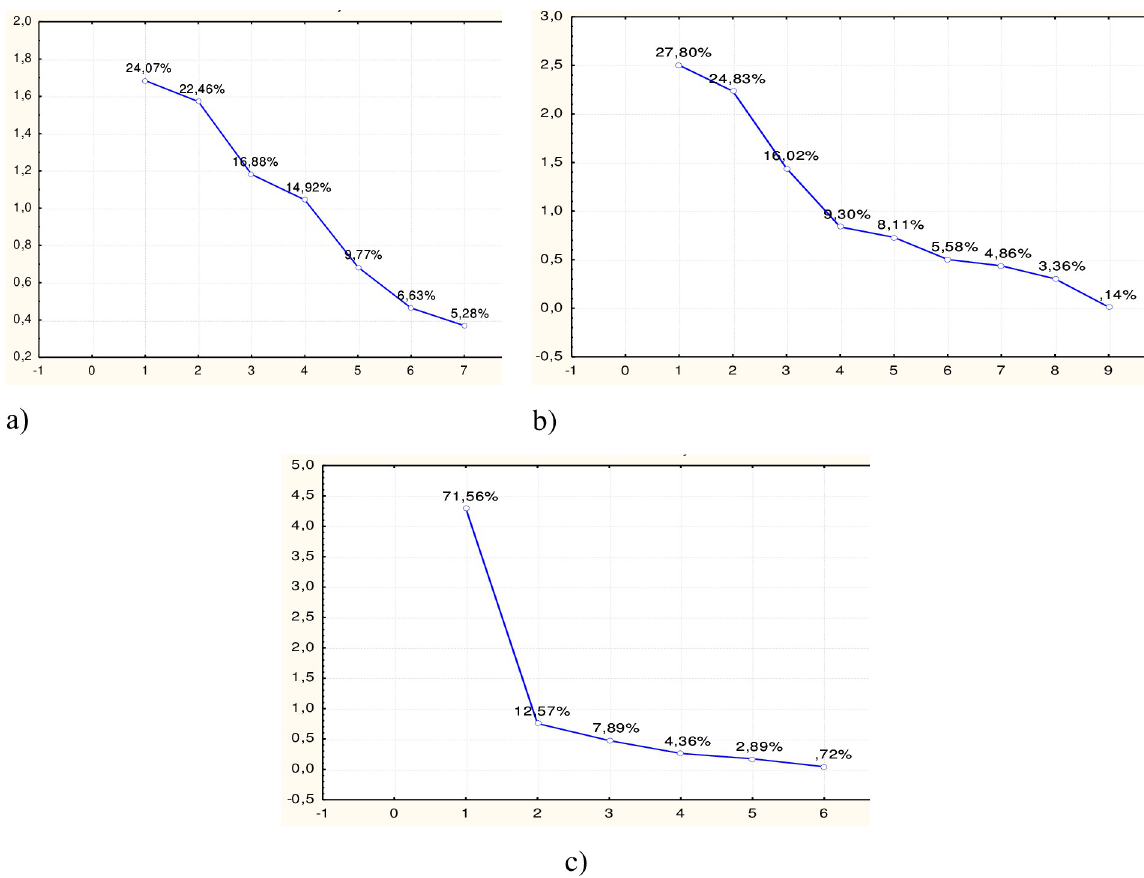
Fig 1. Stony scree for determinants (a–financial-budgetary, b–economic, c–political). Source: own results.